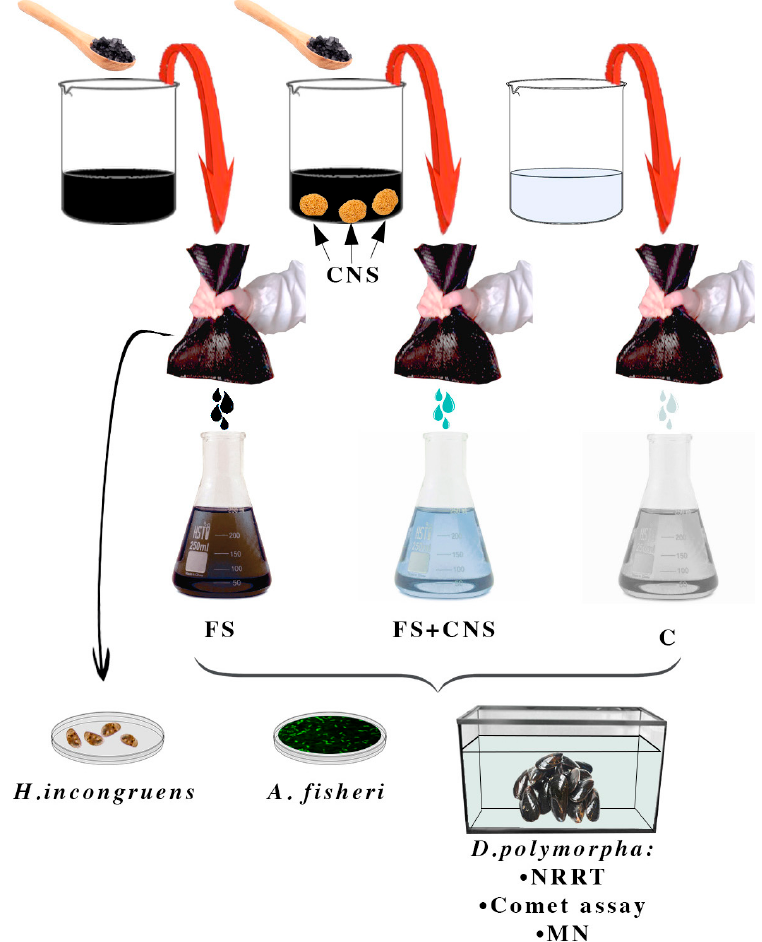
Figure 1. Experimental design. Set-up of three treatment groups: AFW as control (C); water from the industrial canal sludge filtration (FS); water obtained by filtration of sludge previously enriched in CNS (FS + CNS). Filtration was achieved by passing twice the sludge through a fine-mesh net.